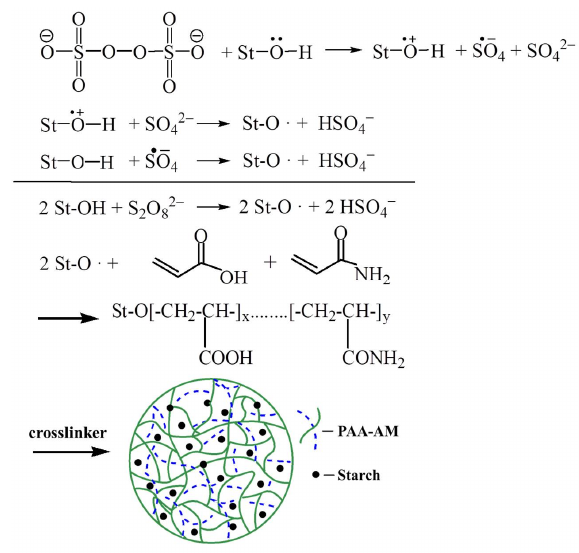
Figure 1. Schematic illustration of polymerization